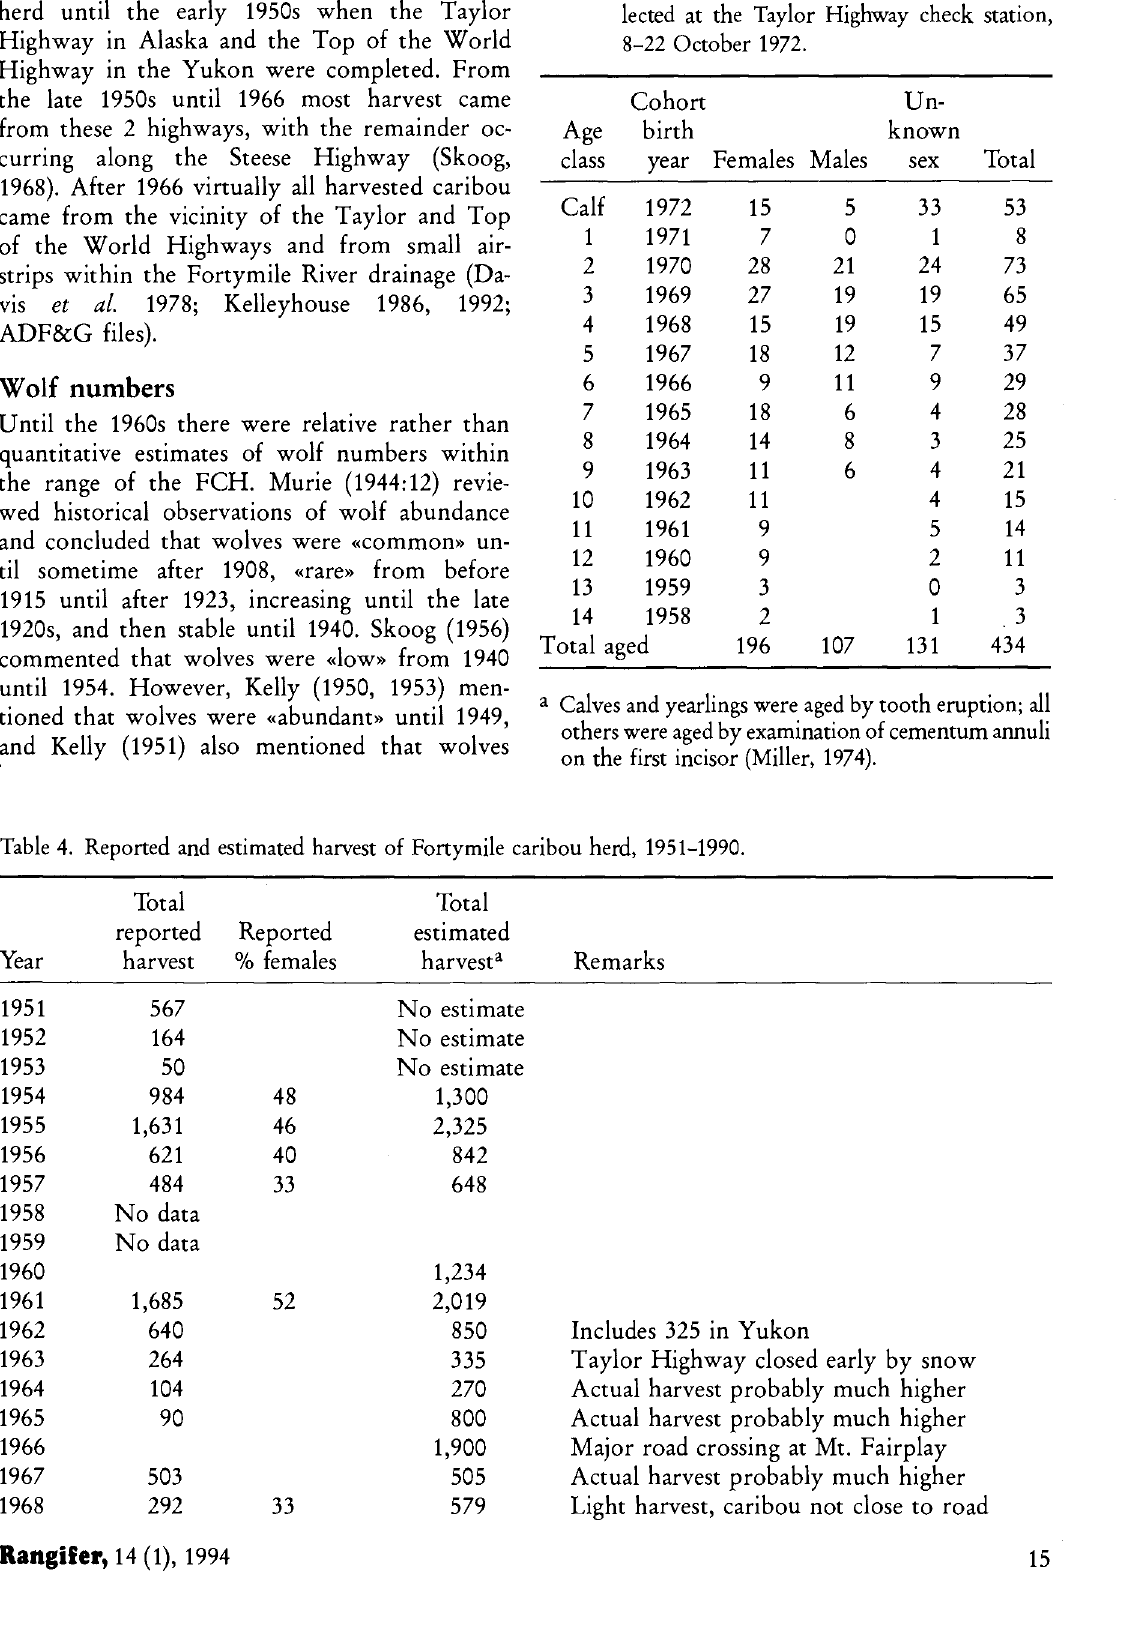
Table 3. Age distribution of 434 caribou mandibles a col